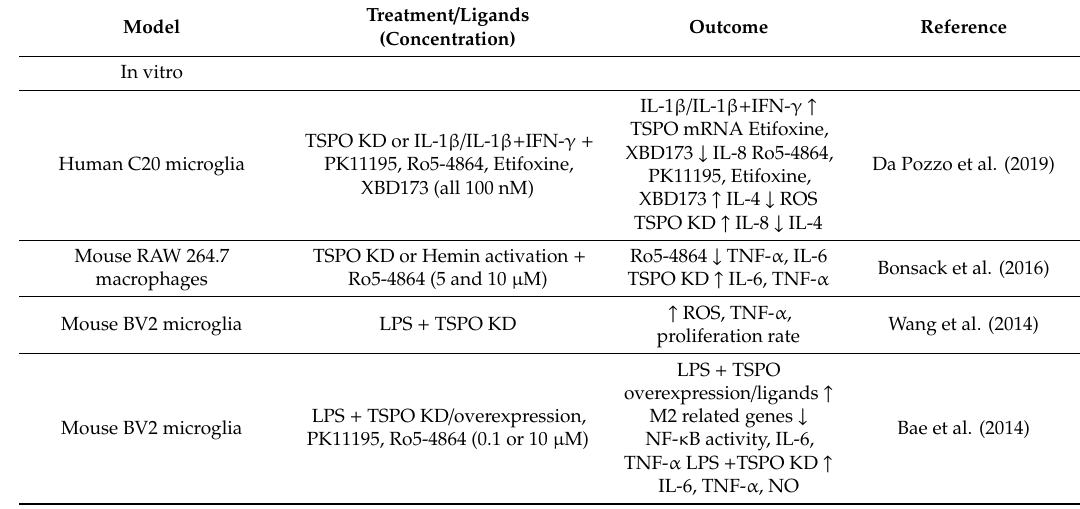
Summary of in vitro and in vivo experimental data describing the role of TSPO in inflammatory